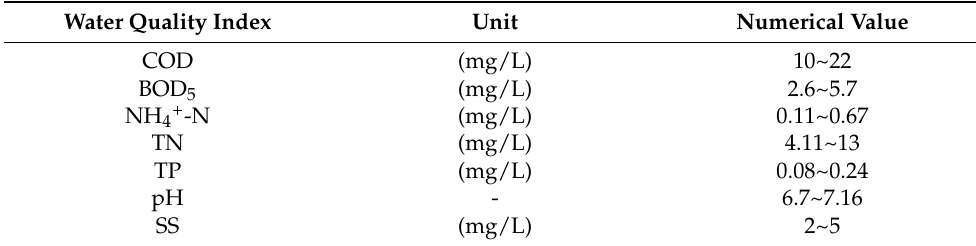
Table 1. Main water quality parameters of experimental water.